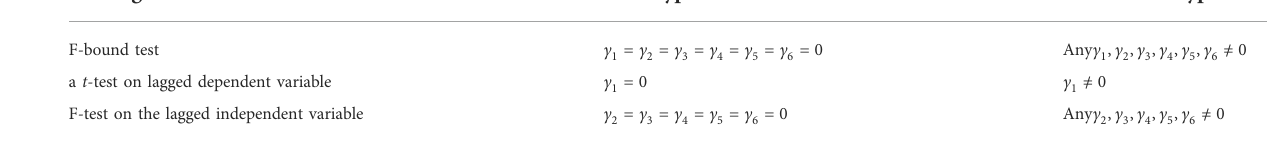
TABLE 2 De fi nitions for the null hypotheses for all three